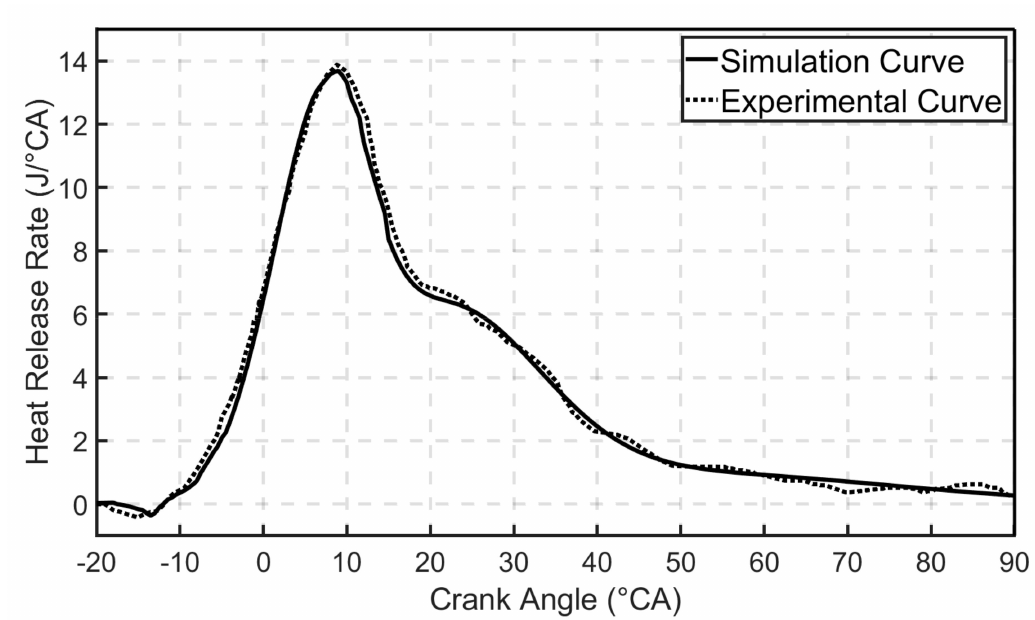
Figure A4. Comparison between heat release curves (full